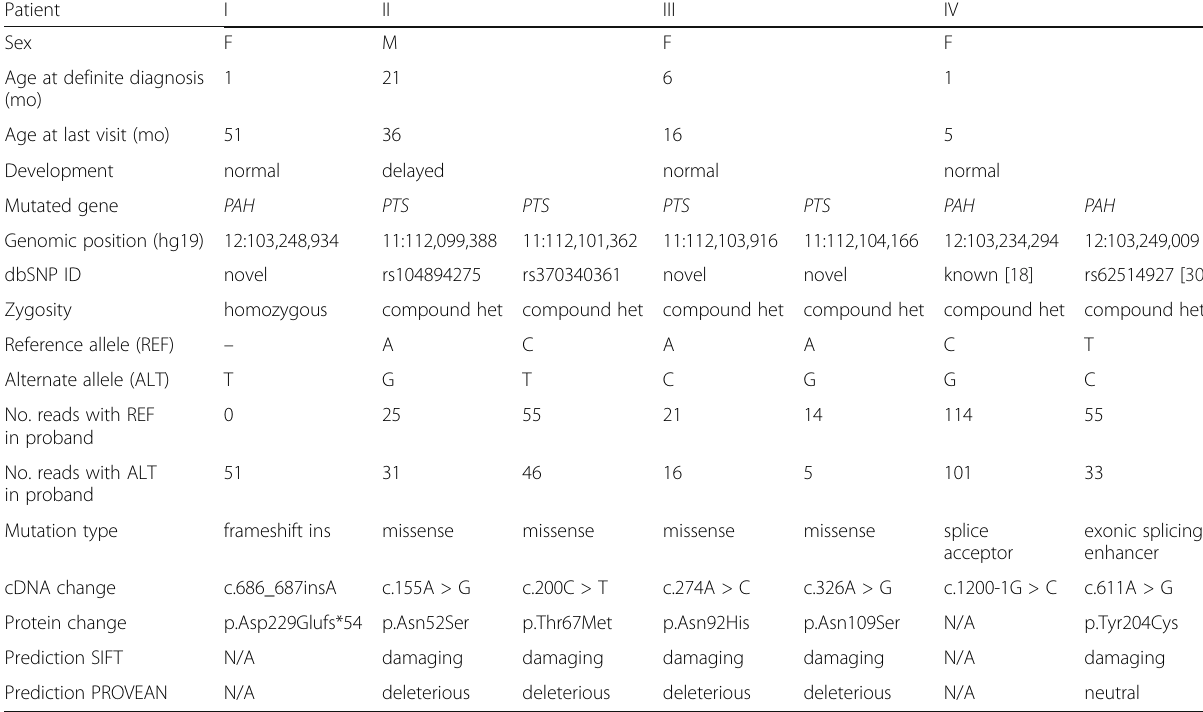
Table 1 Clinical and molecular findings Patient